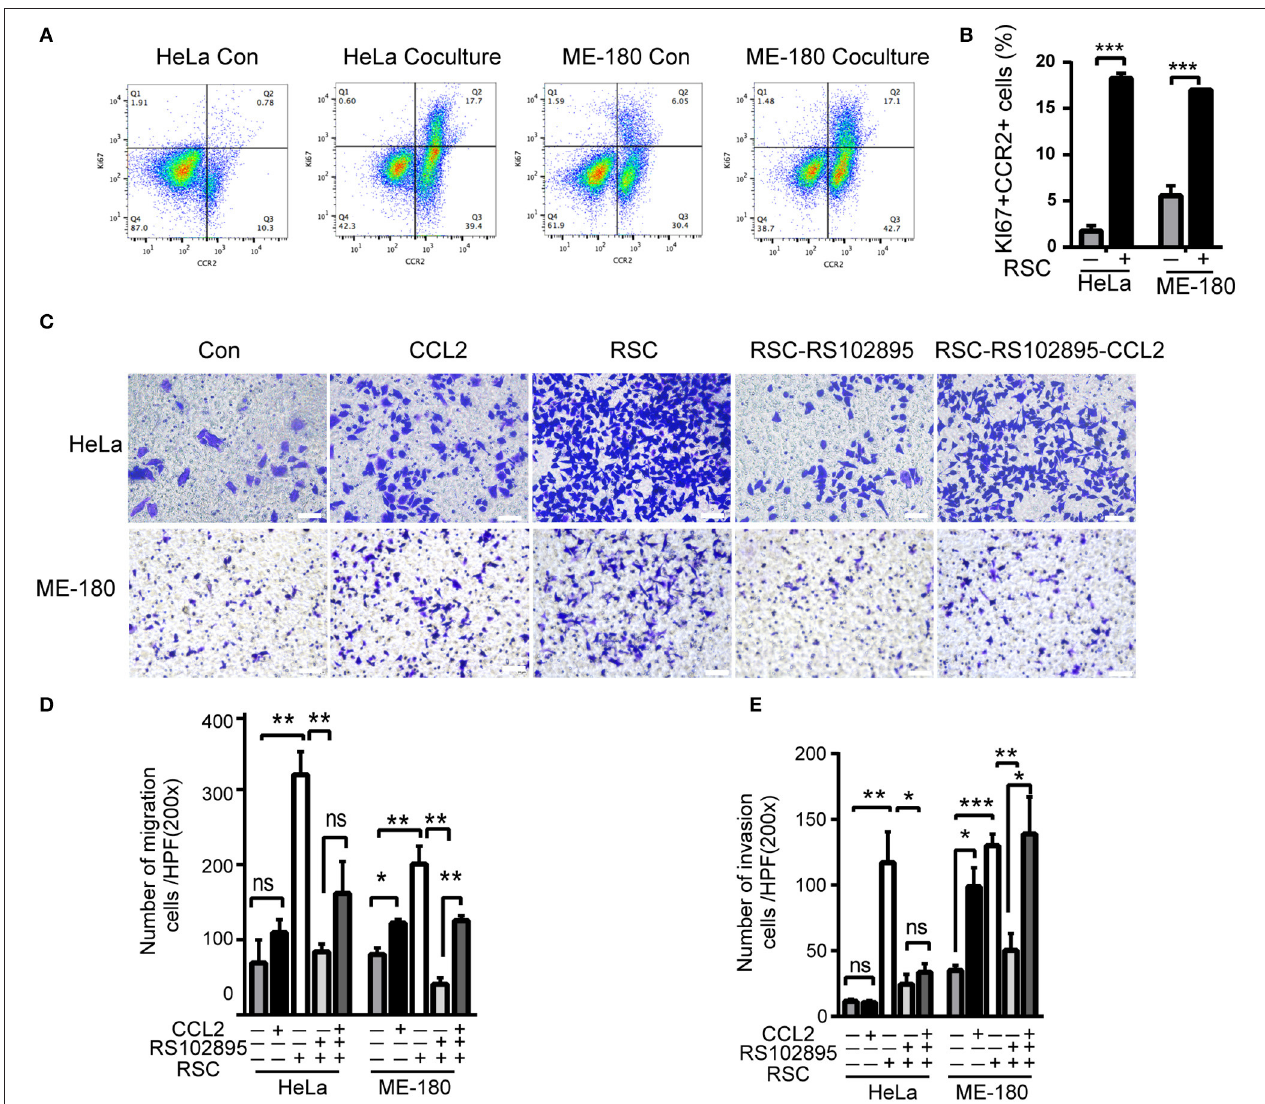
FIGURE 4 | CCL2 promotes cervical cancer proliferation, migration, and invasion. (A,B) Flow cytometry results of phagocytosis assays in which HeLa or ME-180 cells were cocultured with or without SCs. The percentages of Ki + CCR2 + cells are indicated in the upper right corner. ( C–E) Cell migration and invasion assays were performed to assess the effect of RSC, CCL2, and CCR2 on cancer cells. The data are shown as the mean ± SEM. * P < 0.05, ** P < 0.01, *** P < 0.001 and ns, not significant. (D,E) Refer to the statistical results.